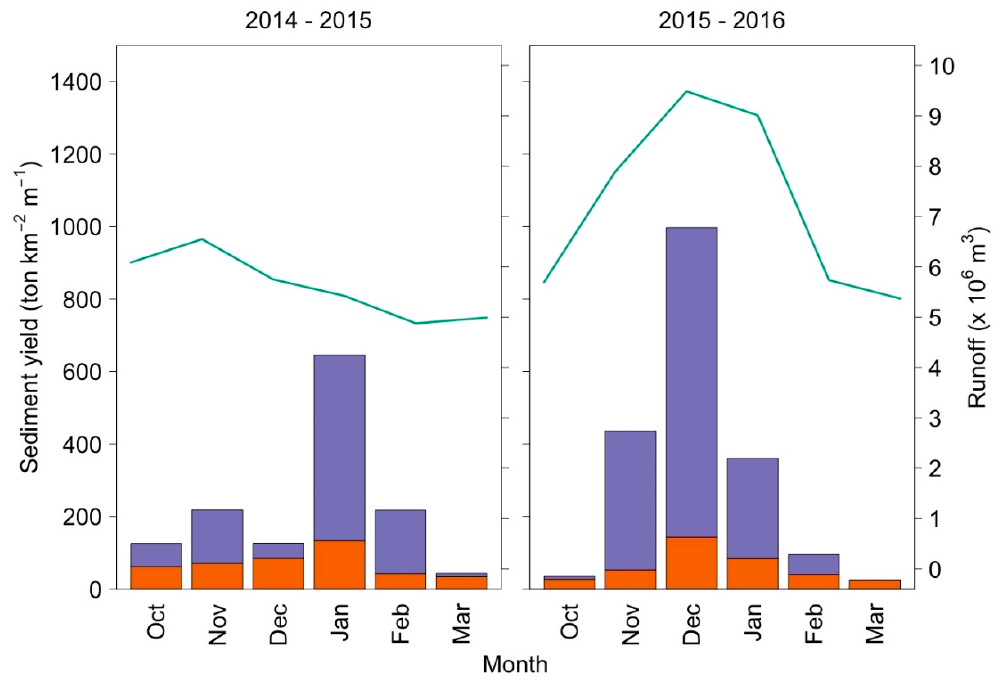
Figure 12. Suspended and bedload transport yield grouped by month in the two ablation seasons. The total monthly runoff is also plotted.